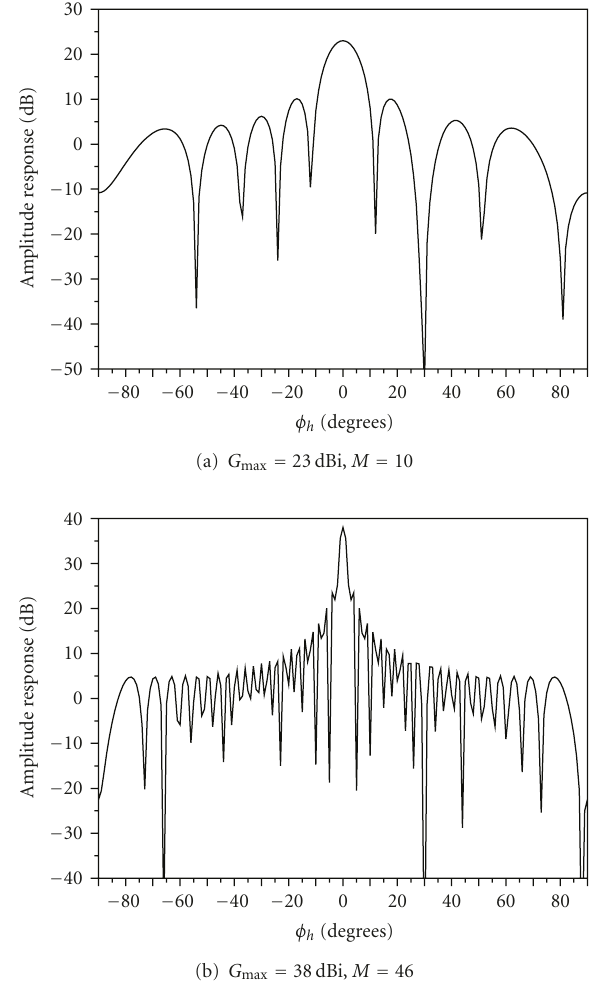
Figure 13: An example of an antenna beam pattern using ABS.